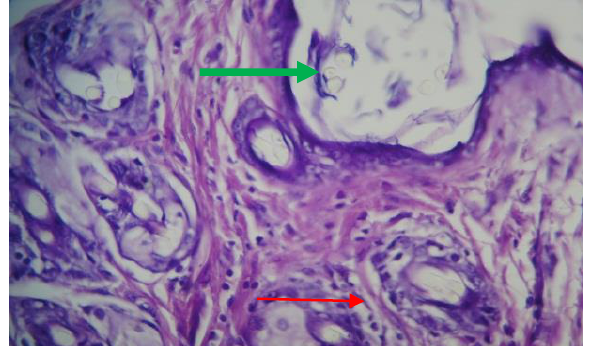
Figure,1: Section in the skin of infected non- immunized animal at day 5 post challenge showed slight keratohyalin layer covered stratum cornium with neutrophil producing abscess in the upper dermis (H&E stain400X).